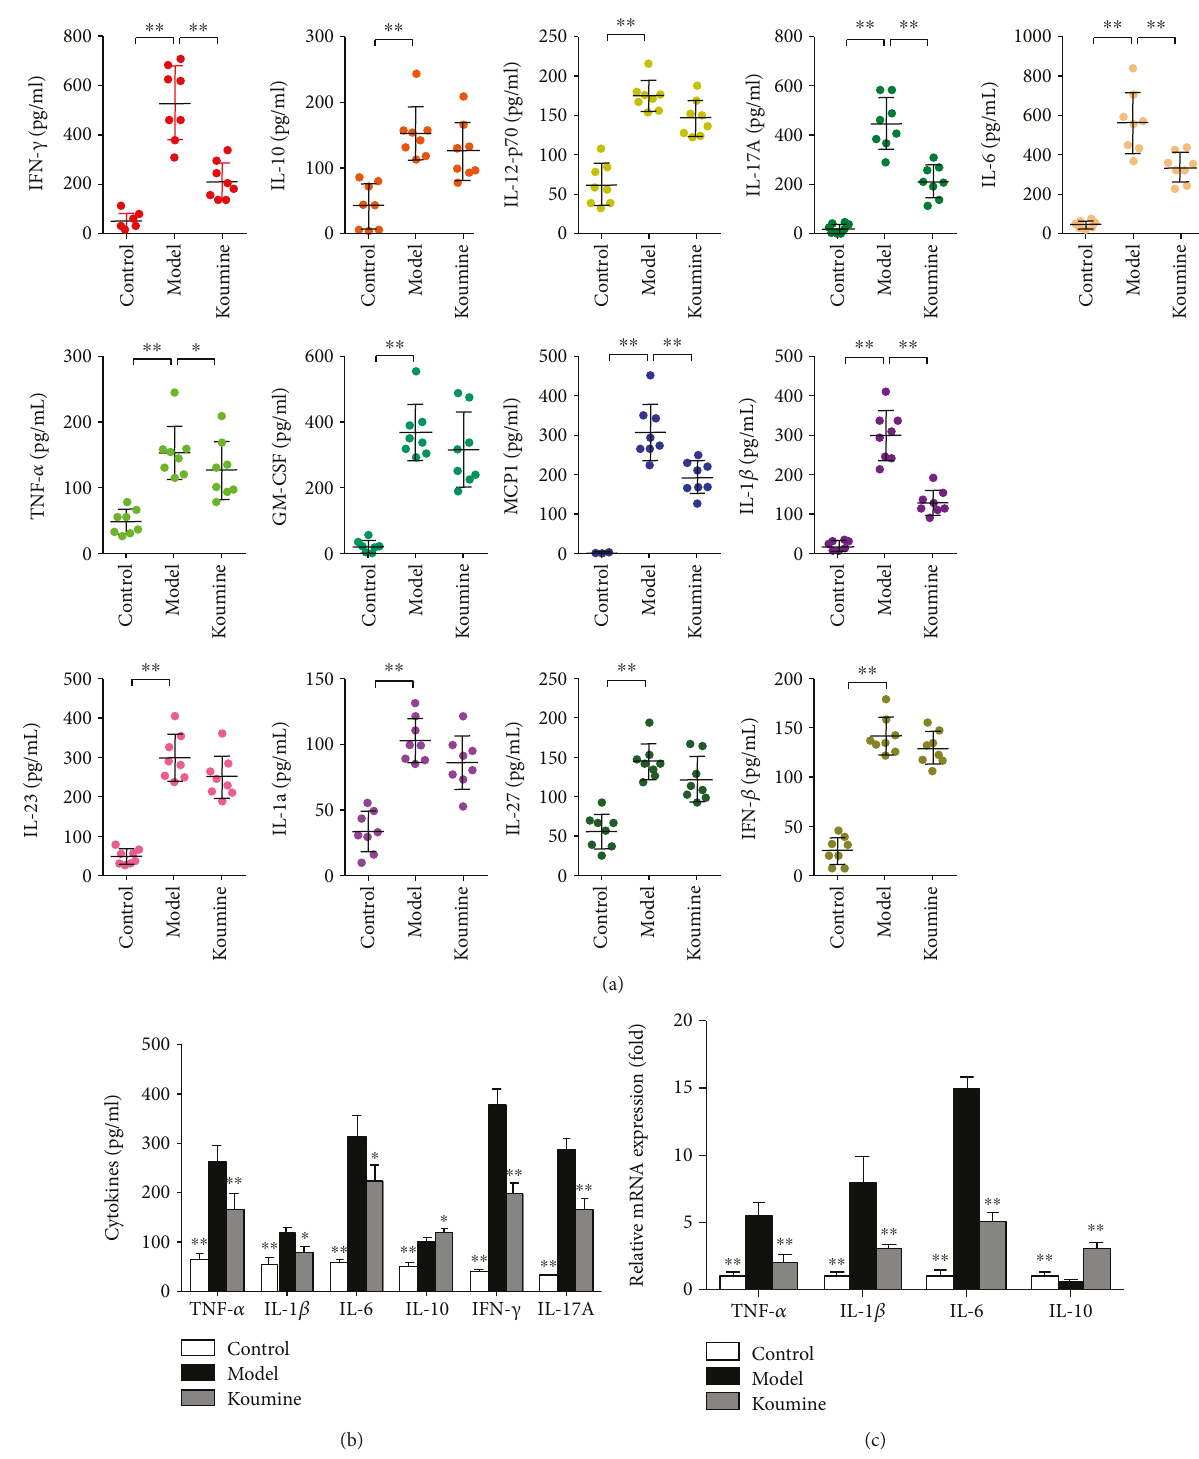
Figure 4: Koumine reduces the production and mRNA expression of cytokines in activated T cells. (a) Model and 1.4mg/kg koumine-treated rats were sacri fi ced to obtain the serum and measured for the cytokines by multifactor detection of fl ow cytometry. (b) The livers were isolated from model and koumine-treated rats, and after being homogenized, the supernatants were harvested to measure the cytokine production by ELISA. (c) The livers were isolated from model and koumine-treated rats, and mRNA expression of selected genes were measured by real-time PCR. Data are means ± SEM ( n = 3 ). ∗ p < 0 05 and ∗∗ p < 0 01 versus model. Data presented are representative of three independent